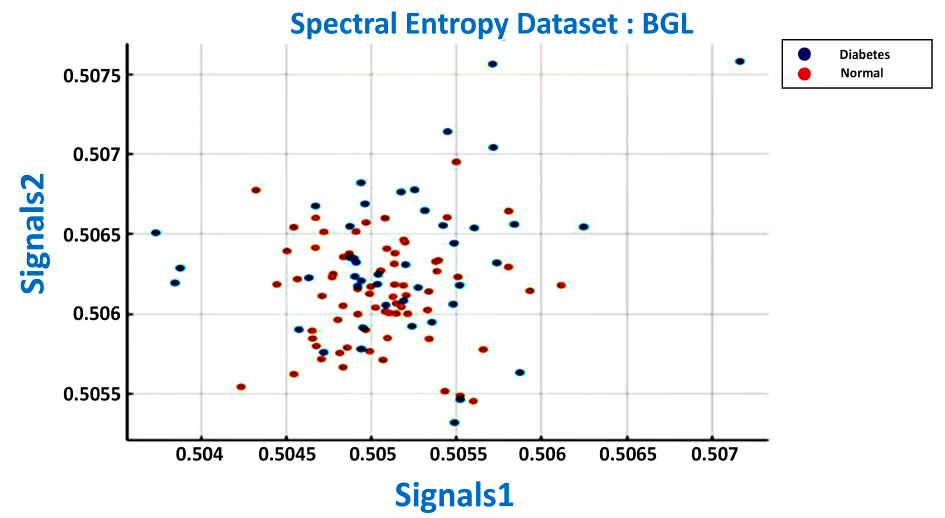
Figure 16. Data distribution of spectral entropy PPG signal. Table 6. Comparative analysis of training results.